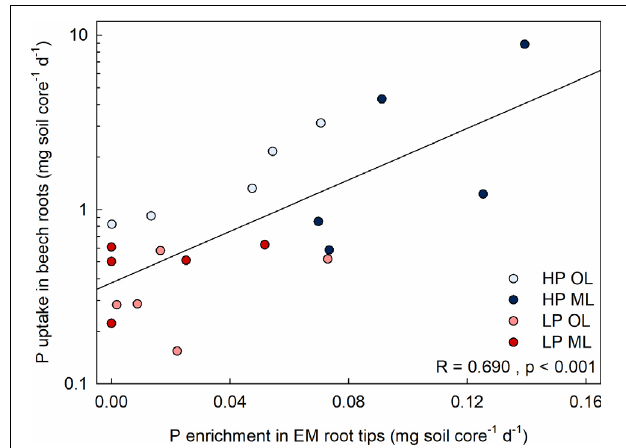
FIGURE 4 | Relationship between the P enrichment in mycorrhizal (EM) root tips and P uptake of beech roots. Symbols indicate individual measurements in soil cores (diameter 0.12 m, height: 0.2 m) from a P-rich (HP) and a P-poor forest (LP) in the organic layer (OL) and in mineral top soil (ML). P uptake was determined 1 day (d) after application of 33 P in artificial soil solution using the specific activities for 33 P sol /P sol in the rhizosphere ( Table 1 ) as described under materials and methods. Regression analysis was done determining Pearson correlation